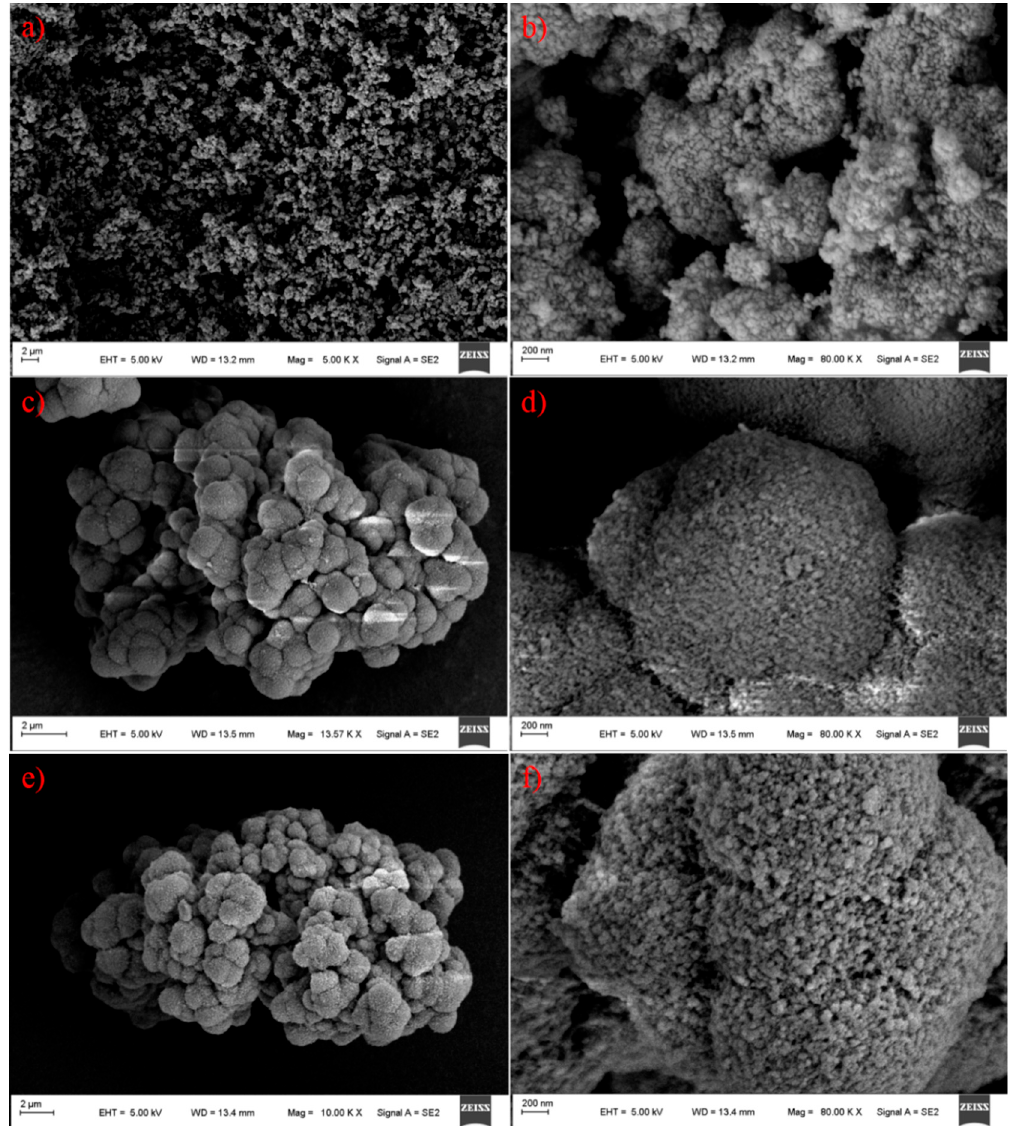
Figure 7. SEM images of TiO 2 and the prepared TiO 2 /POP particles. ( a , b ) TiO 2 nanoparticles; ( c , d ) POP-6; ( e , f ) POP-7.